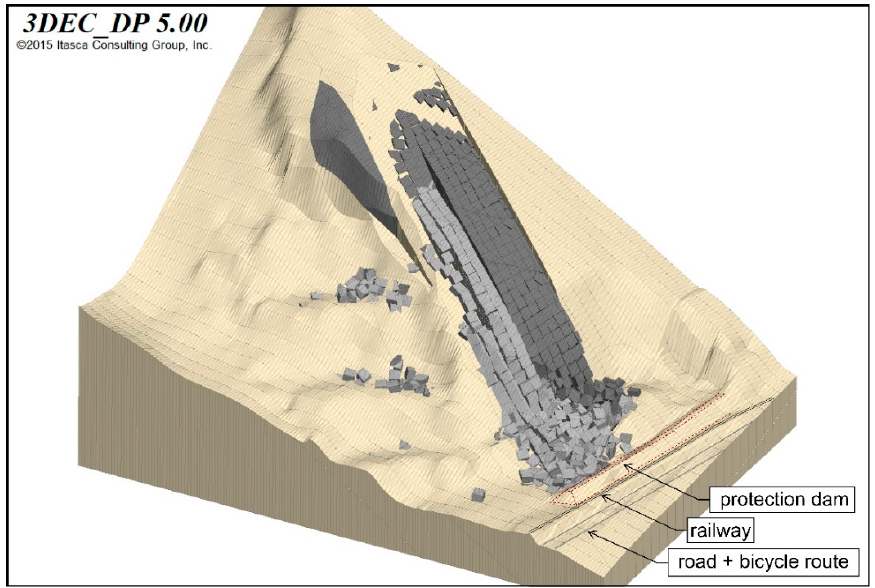
Figure 10. The final state of 3DEC simulation of rockslide of Scenario 2.